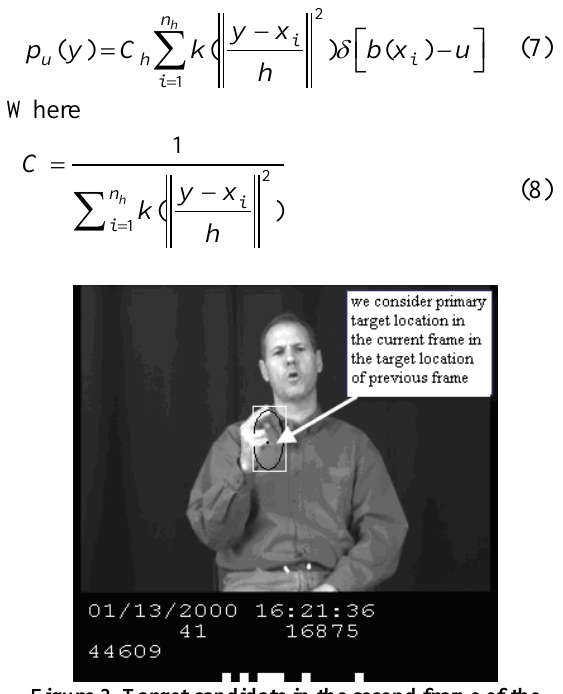
Figure 3. Target candidate in the second frame of the figure